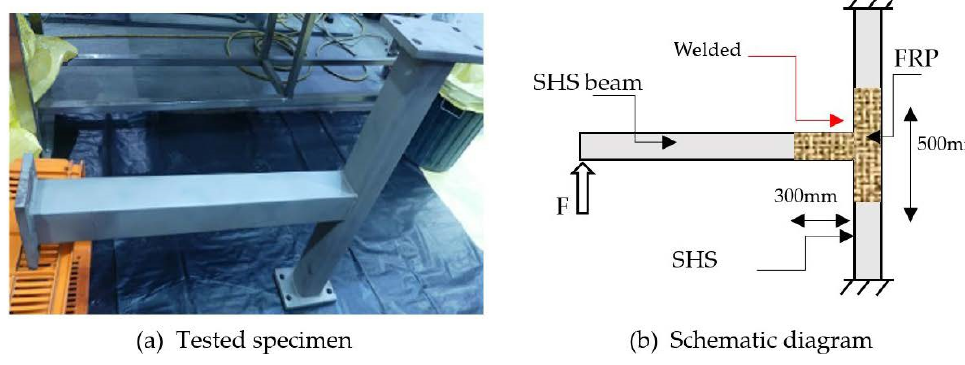
Figure 3. Welded steel connections [2].